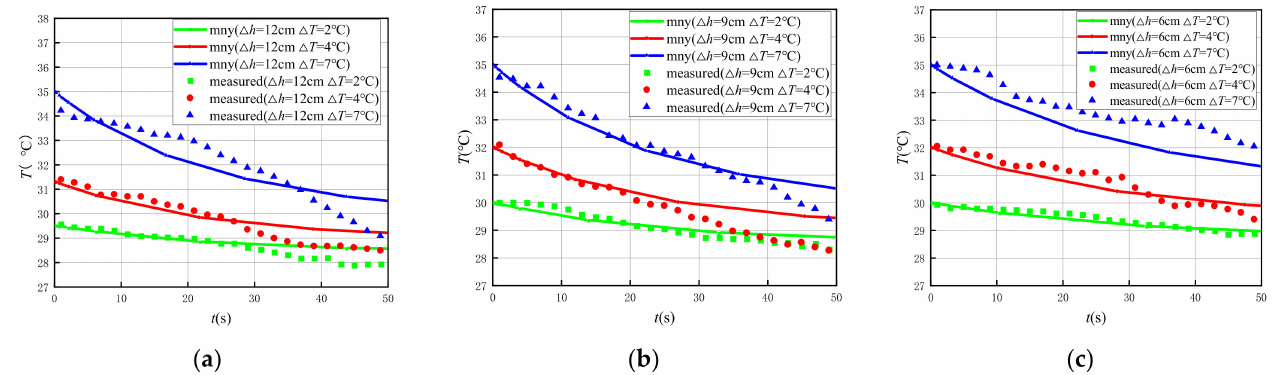
Figure 13. Comparison of temperature variation of test section in the test well under different excitation strengths between numerical simulation and the measured value in the case of u (cid:54) = 0. ( a ) ∆ h = 12; ( b ) ∆ h = 9; ( c ) ∆ h =